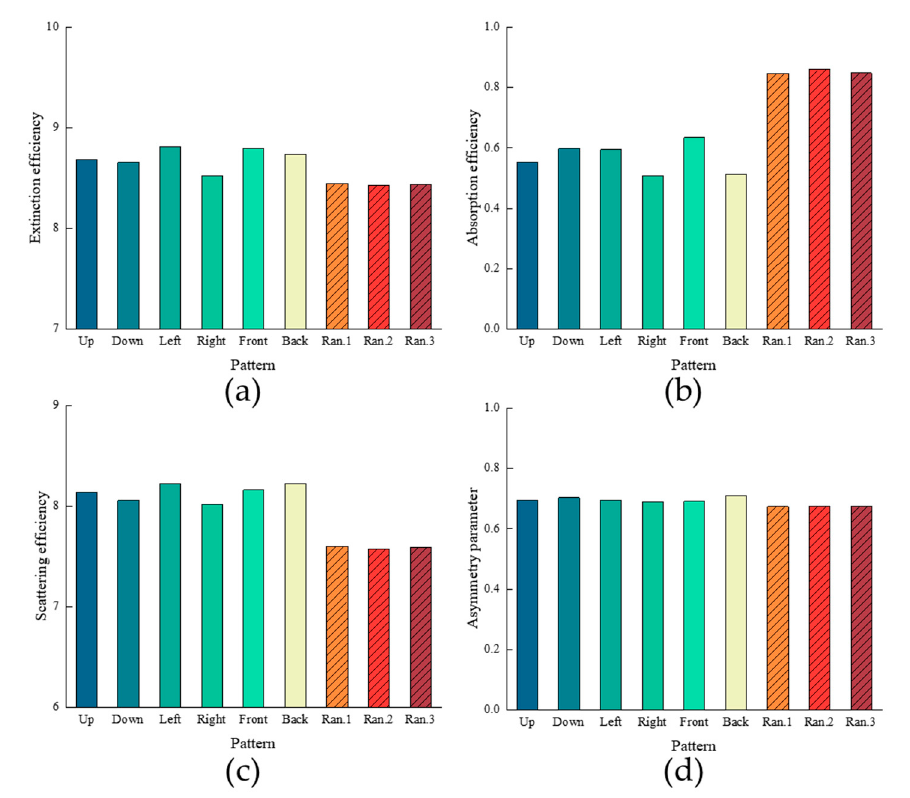
Figure 5. Radiometric properties for particle aggregates of Mode A with different position patterns: up, down, left, right, front, and back are for the minor component particles gathering in the up, down, left, right, front, and back in the aggregate as shown is Figure 2a–c; Ran.1, Ran.2, and Ran.3 are for the minor component particles randomly positioned. Ran.1 is the average result of three different random position patterns, Ran.2 is the average result of six different random position patterns, and Ran.3 is the average result of nine different random position patterns. The refractive indices of the components in the aggregates are m 1 = 1.6, m 2 = 3.102 + 0.0925i, and the particle radius is 2 μ m. ( a ) Extinction efficiency; ( b ) absorption efficiency; ( c ) scattering efficiency; ( d ) asymmetric parameter.